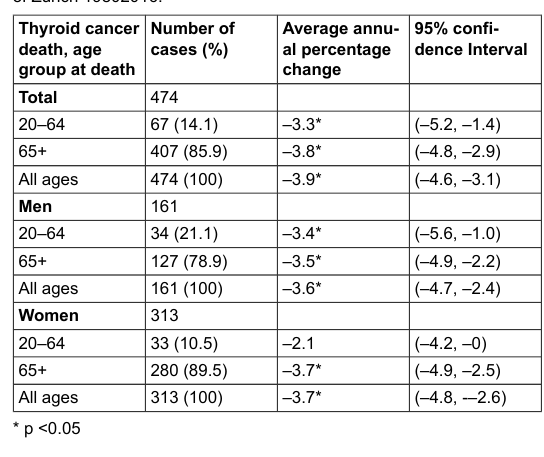
Table 3: Trends in thyroid cancer mortality by sex and age groups in the canton of Zurich